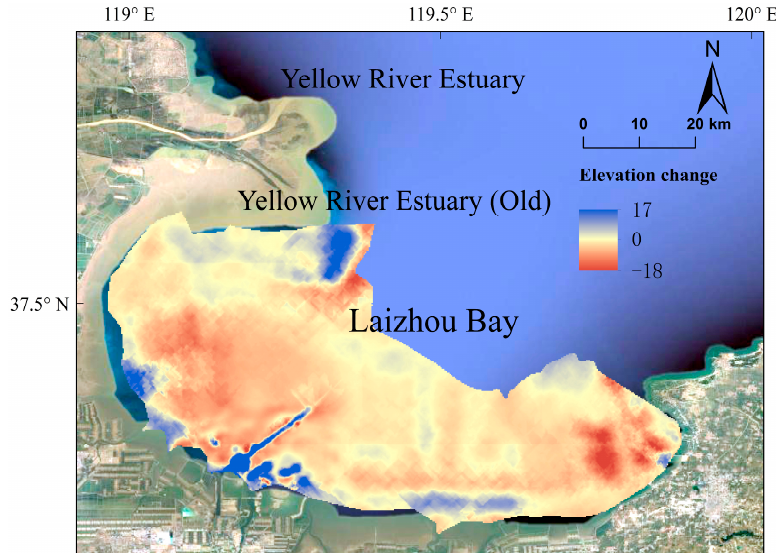
Figure 18. Human impact on the distribution of scouring and siltation (Human activities change the river estuary) .